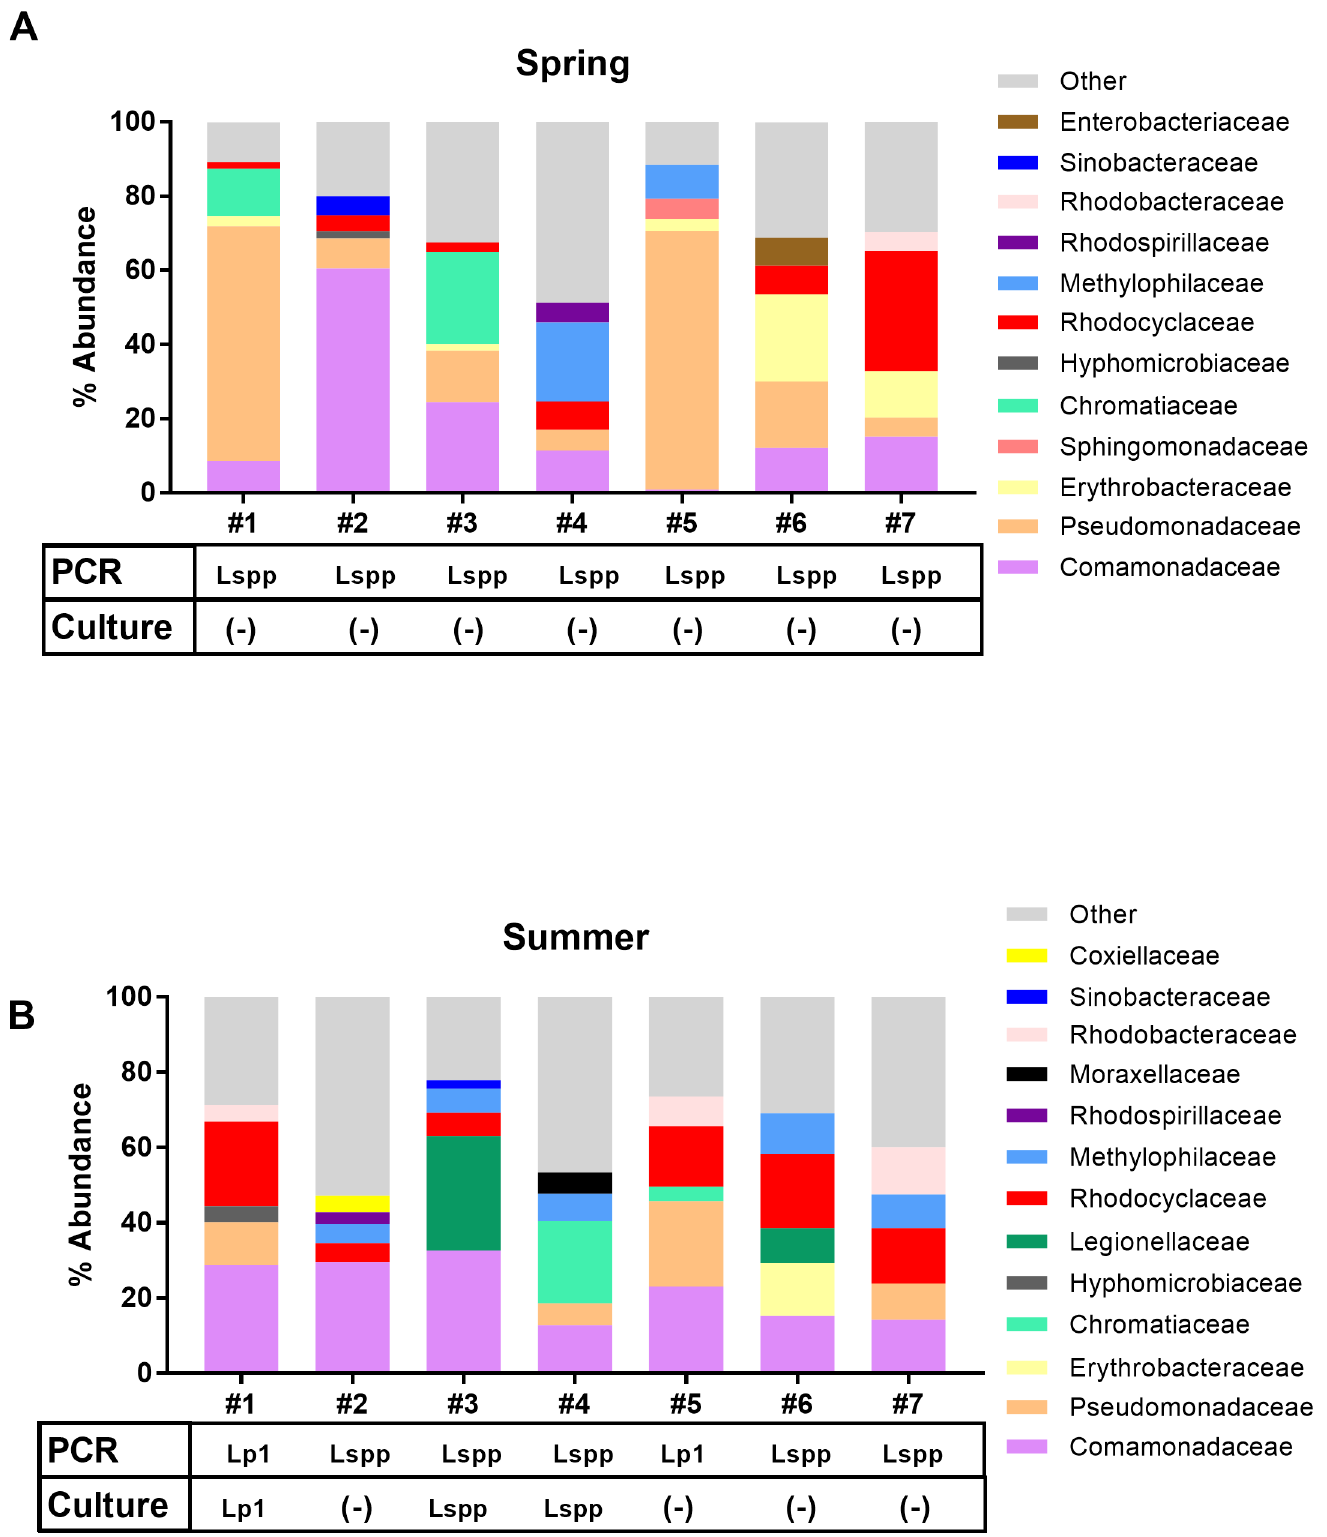
Fig 5. Comparison of Pinellas County CT bacterial family compositions between spring and summer 2016. MultiplexPCR results, culture results, and five highestabundanceProteobacteria family compositionswere comparedbetweenspring (A) and summer (B) 2016. These